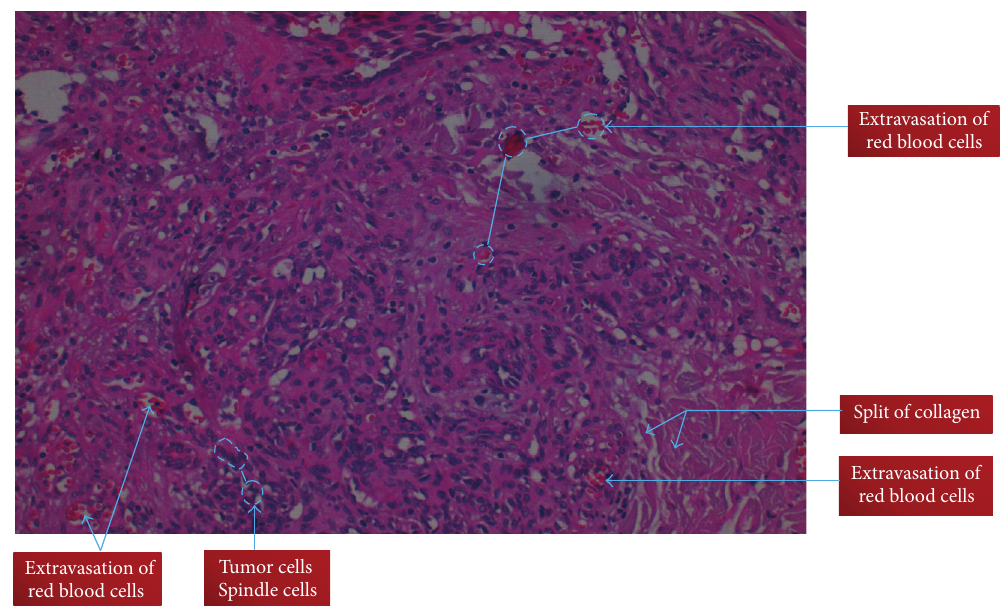
Figure 2: Histological features of Kaposi’s sarcoma of the tongue in HIV positive Maasai